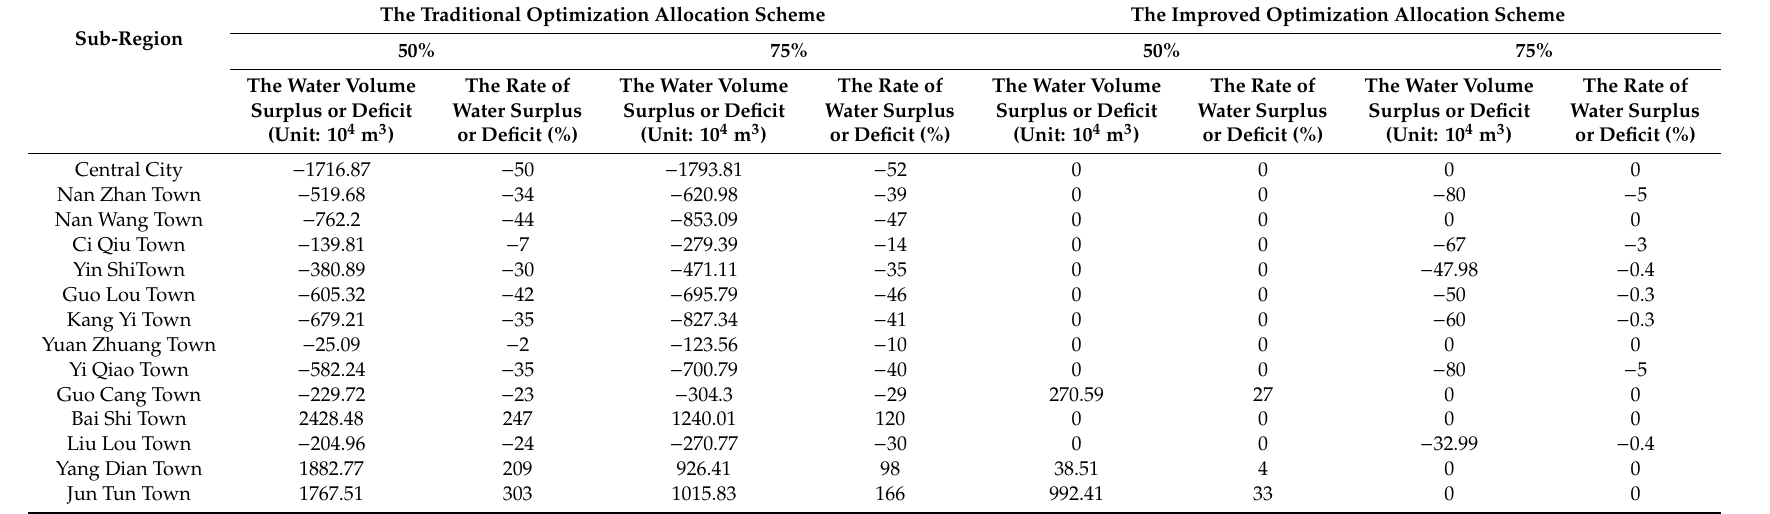
Table 4. Water shortage and water shortage rate before and after the optimal allocation of water resources in